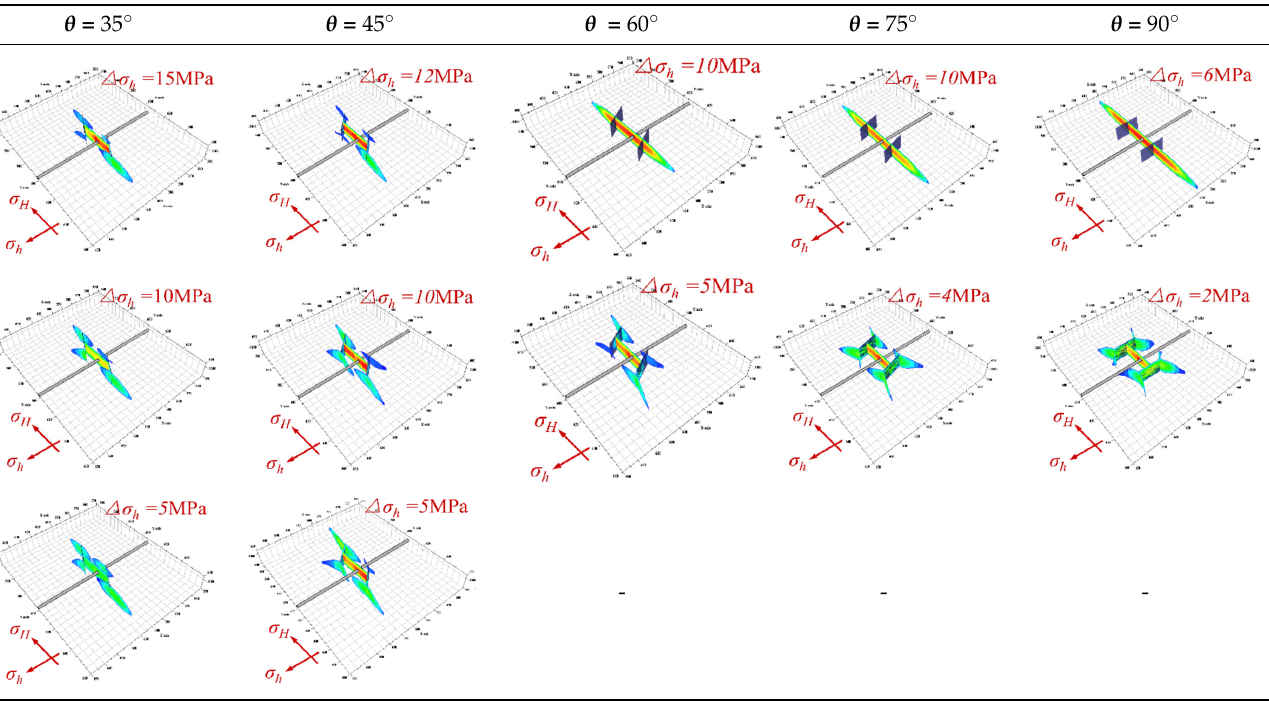
Table 3. Numerical results at different θ and ∆ σ h .